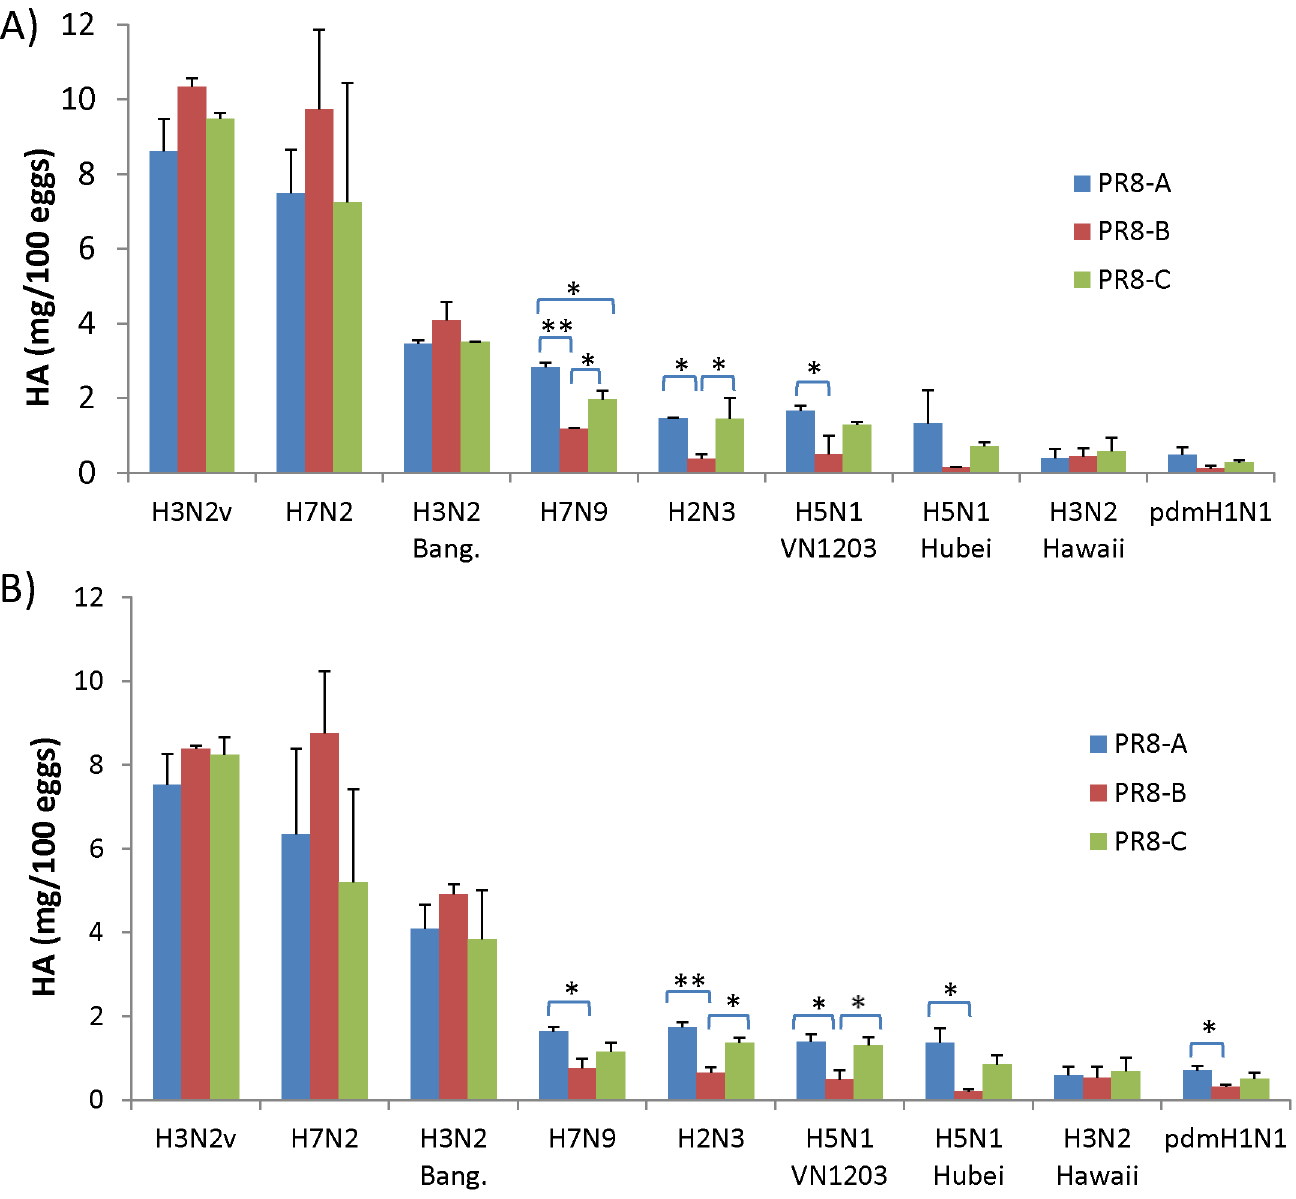
Fig 3. Total HA yield in virus concentrates determined by IDMS and SDS- PAGE/densitometer analysis. Reassortant viruses were propagated in embryonated eggs and purified from allantoic fluid by sucrose density gradient ultracentrifugation. Each virus was propagated and purified at least twice independently using a different batch of eggs. Total HA in concentrated virus samples was determined by IDMS (A) and SDS-PAGE/densitometry (B) as described in Materials and Methods. Statistical significance: * , P < 0.05; ** , P <